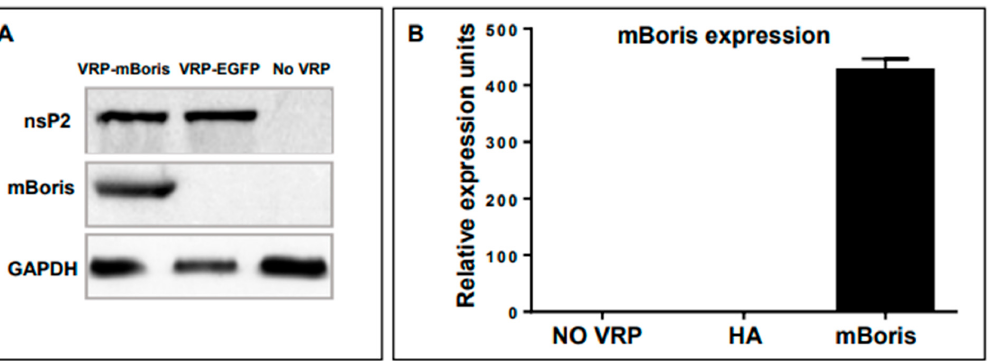
Figure 3. VRP-encoded mBORIS are expressed by transduced BHK cells. ( A ) Transduced cells were lysed with RIPA lysis buffer containing protease inhibitors. Lysates were assessed for VRP-encoded protein expression by Western Blot. All lysates from cells transduced with VRP expressed the VRP non-structural protein nsP2. ( B ) RNA was isolated and used for first-strand cDNA synthesis. The expression of VRP-encoded mBORIS was determined by real-time qPCR. Expression of a particular VRP-encoded tumor antigen sequence was observed only in BHK cells that had been transduced with VRP-encoding that particular sequence. Data are representative of >3 experiments.